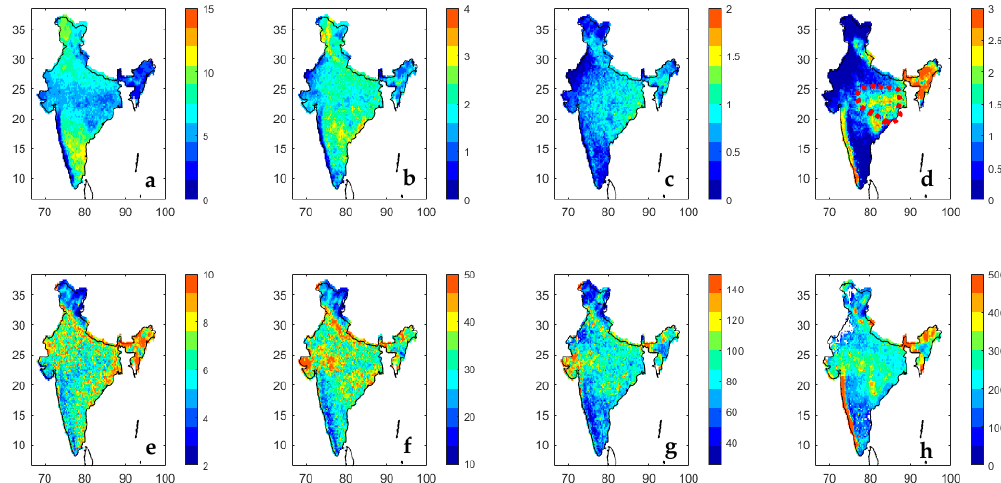
Figure 7. Spatial distribution of rainfall (mm) for continuous 1DAY, 3DAY, 6DAY, and 11DAY for L-period ( a – d ) rainfall frequency ( e – h ) rainfall fraction. Low pressure is dotted by magenta in Figure 7d.